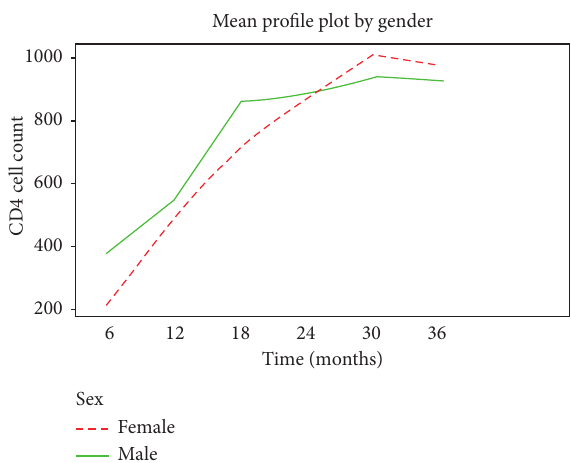
Figure 2: Mean profile plot of the longitudinal CD4 cell count by gender.